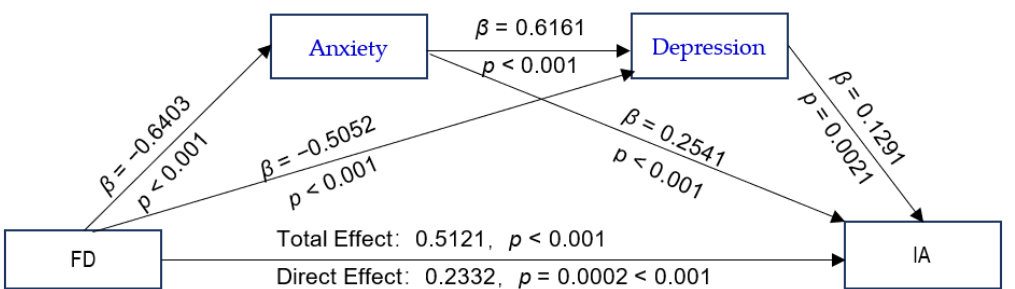
Figure 2. The chain-mediated model predicting adolescents’ IA based on the experience of childhood trauma mediated by anxiety and depression. Abbreviations: CT, childhood trauma; IA, Internet addiction.